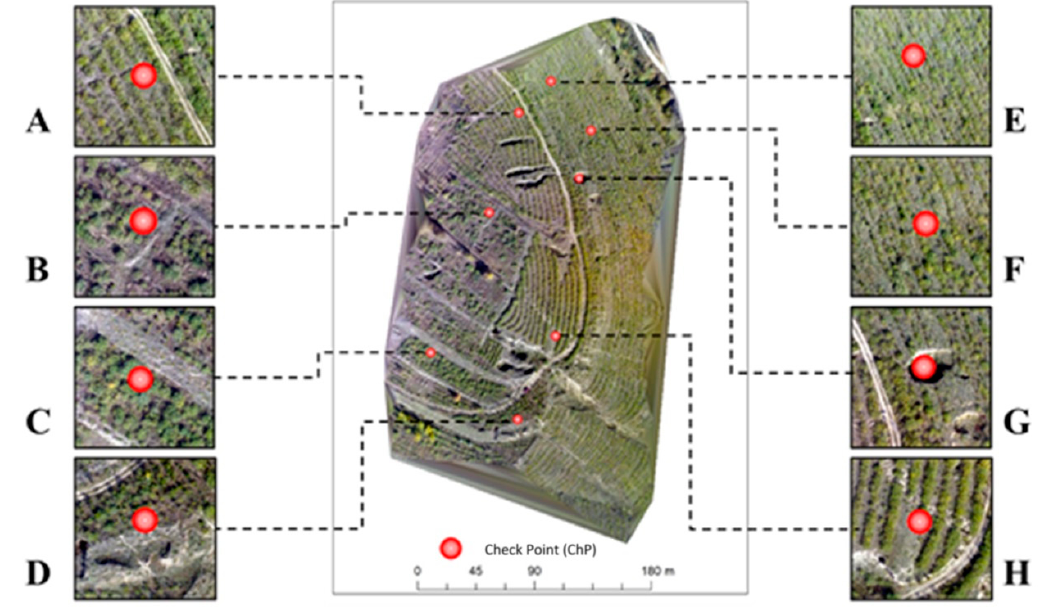
Figure 7. Elevation uncertainty assessment in Xining.